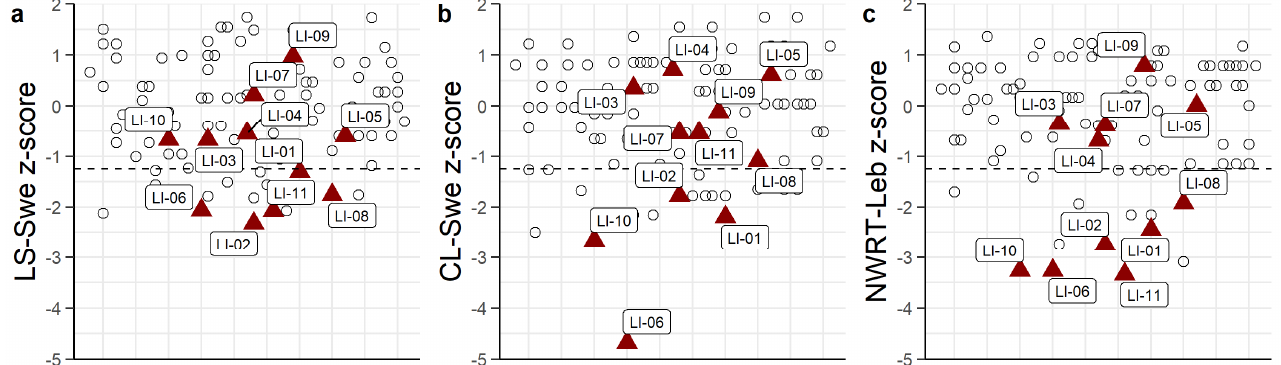
Figure 4. Scatterplots showing age-adjusted z-scores of the ( a ) LS-Swe, ( b ) CL-Swe and ( c ) NWRT-Leb tasks of the children in the DLD sample (triangles and labels) compared to the children in the TD sample (circles). Dashed lines at − 1.25.